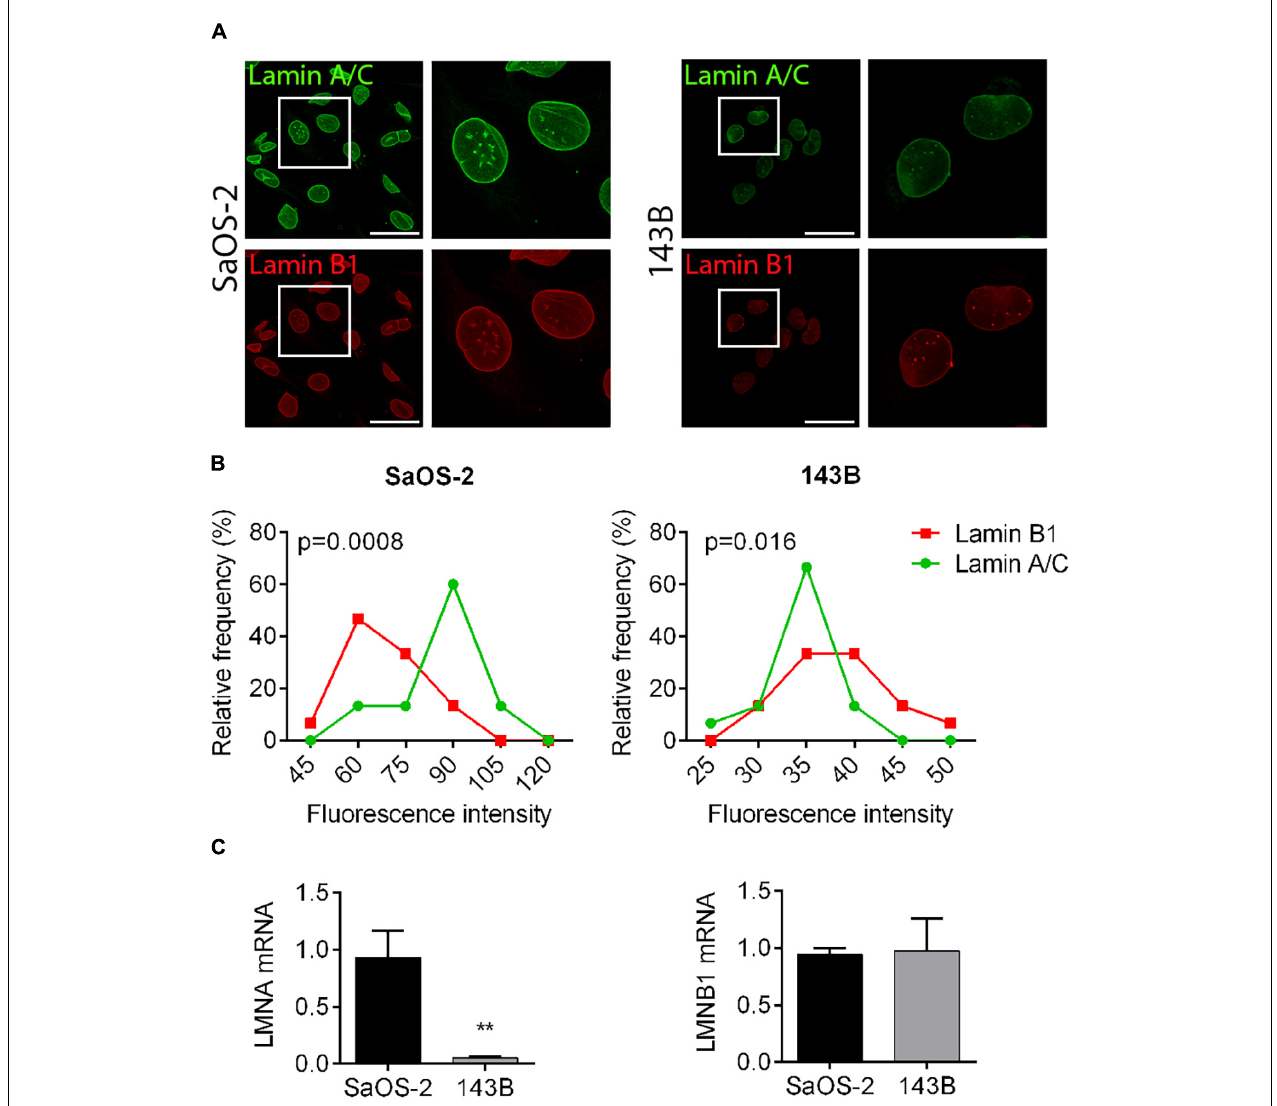
FIGURE 1 | Lamin A/C and B1 expression in osteosarcoma cell lines with different aggressiveness. (A) Representative pictures of the immunofluorescence analysis of Lamin A/C (green) and Lamin B1 (red) in SaOS-2 and 143B cells. Bar: 50 µ m, n = 100. (B) Frequency distribution of fluorescence intensities of Lamin A/C (green line) and Lamin B1 (red line) in SaOS-2 and 143B cells. (C) mRNA expression of LMNA and LMNB genes in SaOS-2 and 143B cells, normalized versus GAPDH gene expression. ** p <